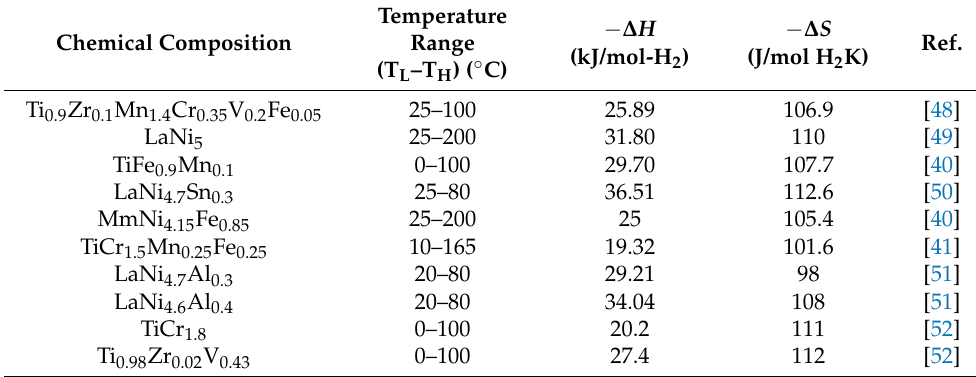
Table 1. Thermodynamic properties of hydride-forming alloys for the absorption process. Chemical Composition